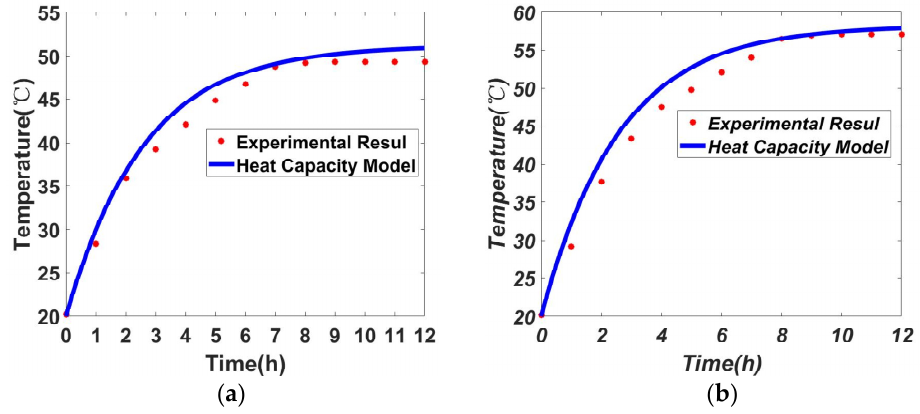
Figure 15. Transient curve of node temperature: ( a )Node 2; ( b )Node 4.